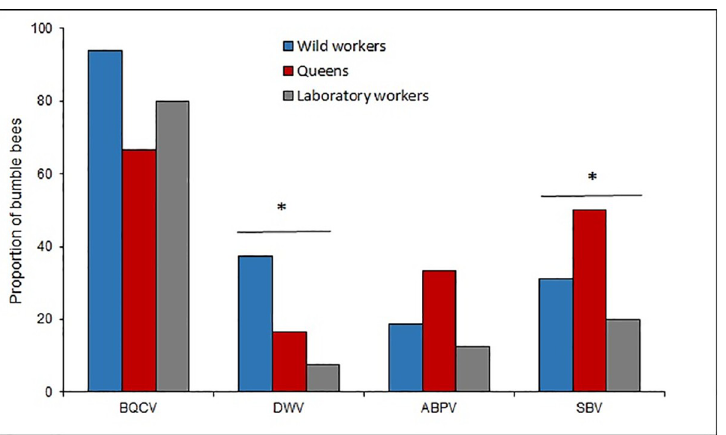
Fig 2. Prevalence of BQCV, DWV, ABPV and SBV in laboratory workers, wild workers and queens. The asterisk � indicates significate differences (P < 0.05) between the bumble bee groups for the Chi-square test.